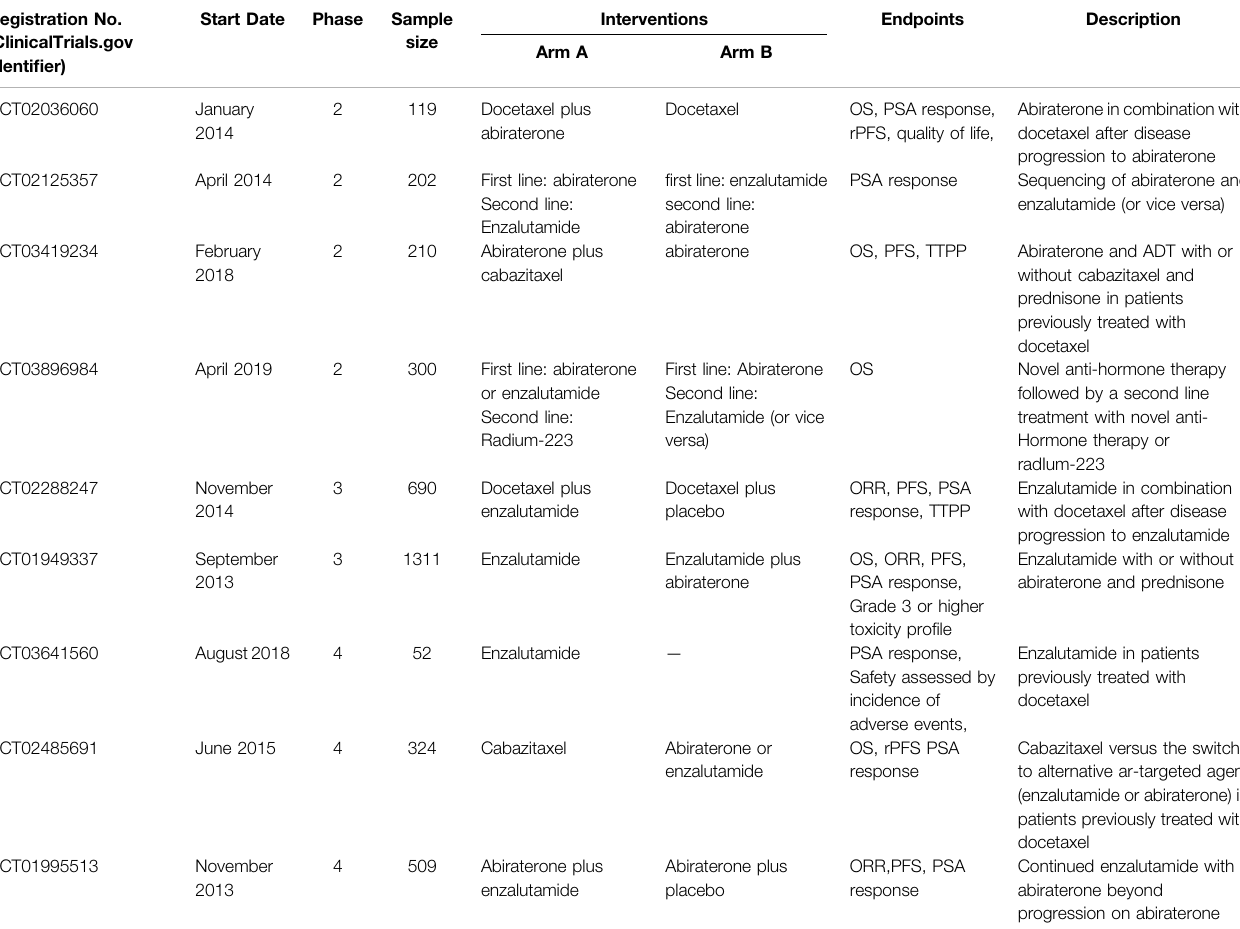
TABLE 2 | Ongoing Clinical Trials in Metastatic Castration-Resistant Prostate Cancer Registration No.